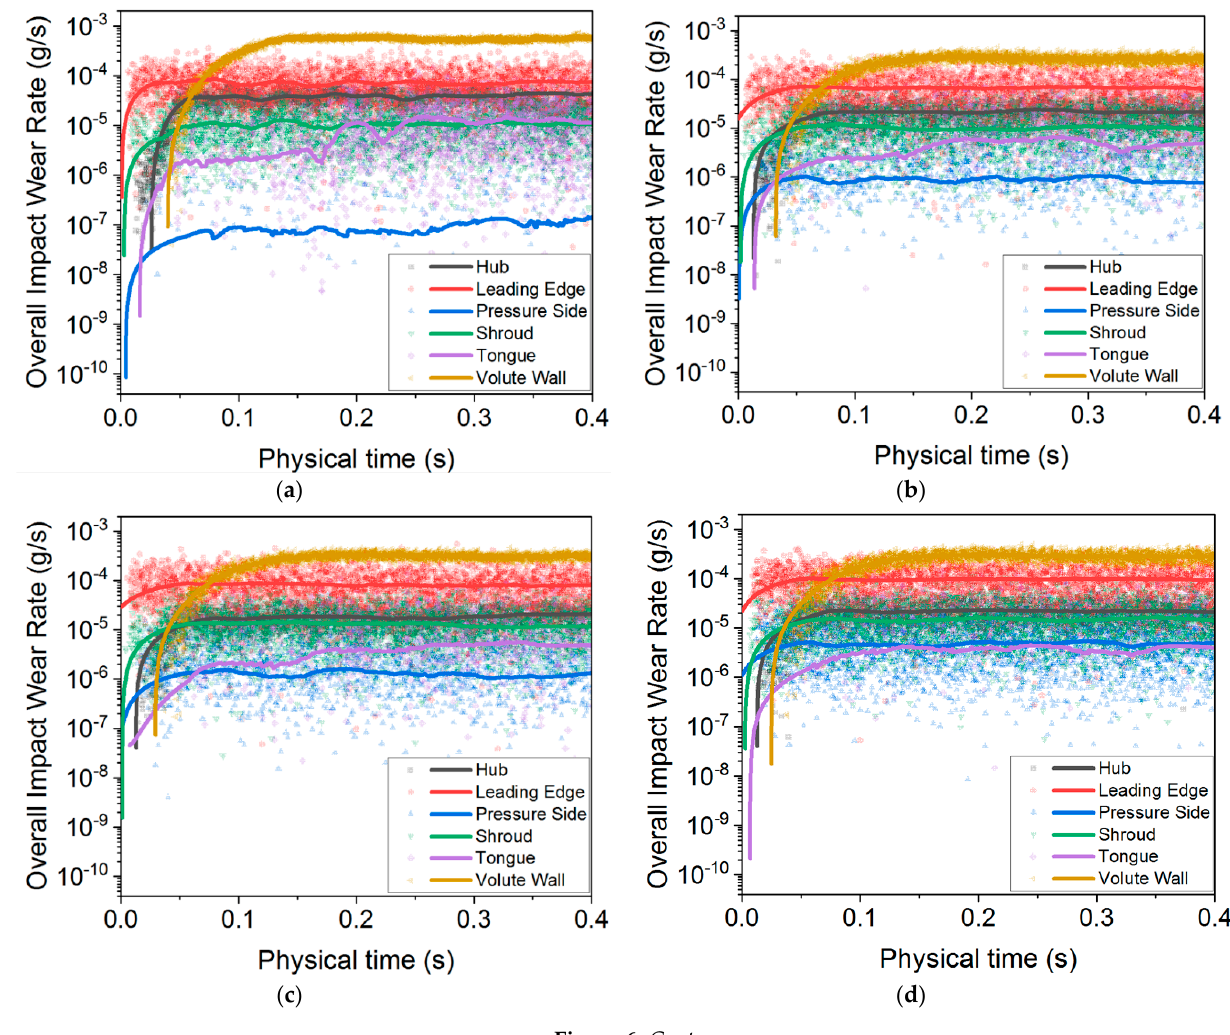
Figure 5. Trajectory and distribution of different particles: ( a ) tetrahedron, ( b ) hexahedron, ( c ) octahedron, ( d ) dodecahedron, and ( e ) sphere.